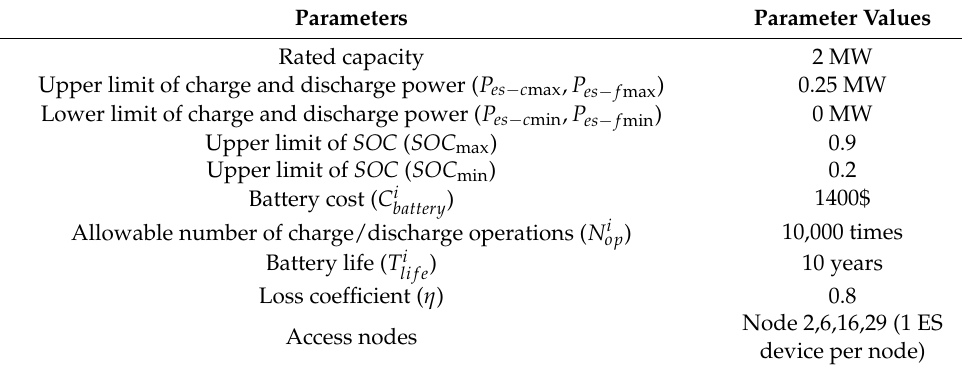
Table A3. Parameters of ES devices.